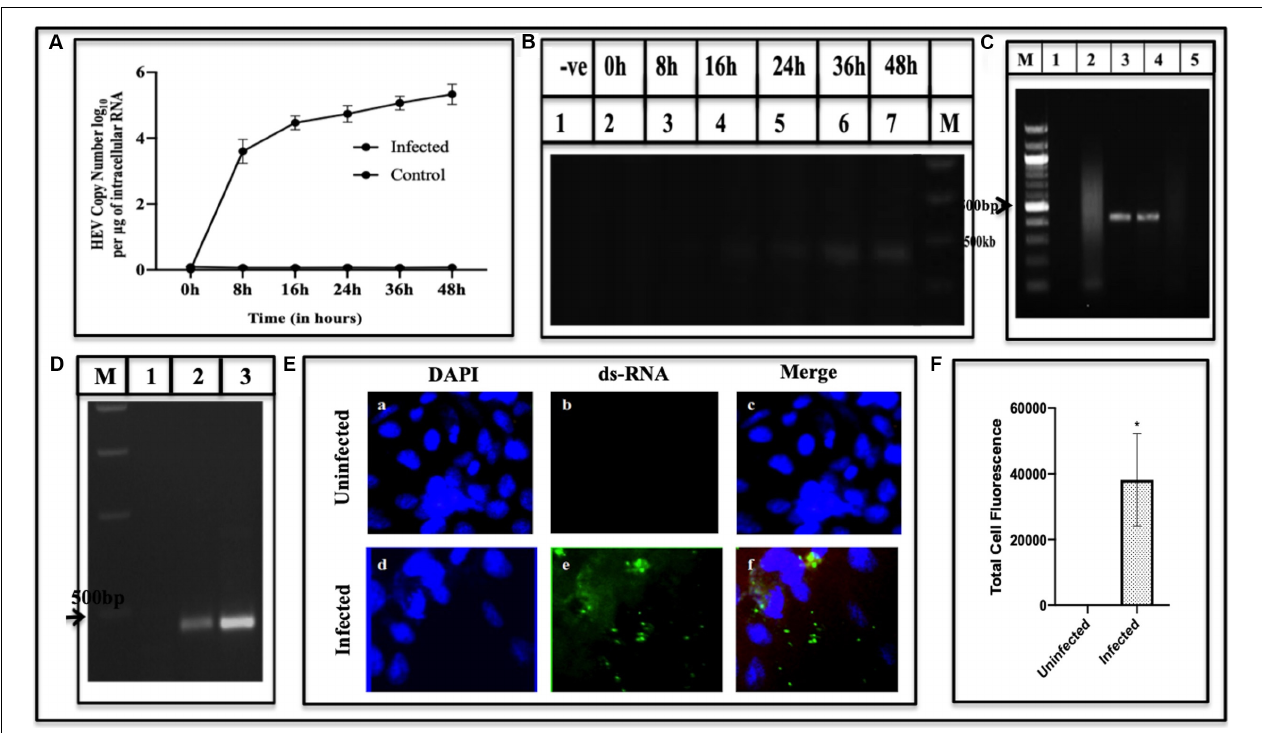
FIGURE 2 | Quantification and detection of viral RNA. (A) Viral RNA copies in Huh7 cells were quantified at different time points (0–48 h) using qPCR. The graph indicates the HEV copy number in log 10 per microgram of total intracellular RNA. Error bar indicates the standard deviation. (B) Amplification of cDNA generated by RT-PCR of viral RNA isolated from infected cells at the corresponding time using primers GT3RTF and GT3RTR ( Supplementary Table S1 ). The amplified products were fractionated on 1.4% agarose gel (B) . Lane M; Marker, Lane 1, Uninfected; 2–7 indicate amplified product from infected cells at different time points (0–48 h). Detection of Negative and Positive Strand of RNA. (C) RNA supernatanted from the cellular lysate of Huh7 infected cells followed by DNase treatment was used as a template for PCR using primer against ORF2 region ( Supplementary Table S1 ). The corresponding lanes are as follows: Lane M, Marker; Lane 1, uninfected cells RNA followed by cDNA synthesis used as a template; Lane 2, infected cells RNA sample with DNase treatment; Lane 3, infected cells RNA with DNase treatment followed by cDNA synthesis and used as a template; Lane 4, GT3 Plasmid as a positive control; Lane 5, no template control. (D) Detection of negative and positive strand of viral RNA using strand-specific reverse transcription-PCR (RT-PCR). The corresponding lanes are as follows: Lane M, Marker; Lane 1, mock; Lane 2, negative-strand; Lane 3, positive-strand. Visualization of dsRNA in infected cells using Immunofluorescence. (E) Cells were stained with anti-dsRNA (J2 Monoclonal Antibody) detected with Alexa Fluor 488 Rabbit Anti-Mice IgG secondary antibody and counterstained with DAPI to stain nuclei. Panels (a–c) represent uninfected Huh7 cells and panels (d–f) represent HEV infected cells. Panels (c,f) represent the merged image. (F) Quantification of fluorescence. It was done using ImageJ Software. The graph represents the mean fluorescence intensity, and the error bar indicates the standard deviation. The statistical significance of data was tested using the Mann–Whitney test ( p -value = 0.0286). * indicates p -value < 0.05. All experiments were performed at least three times as independent